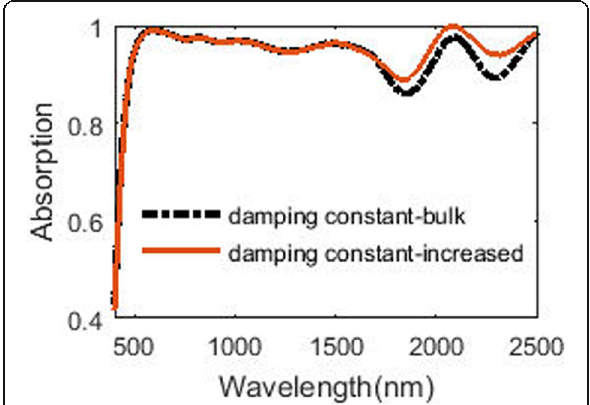
Fig. 15 Absorption using different damping constant of